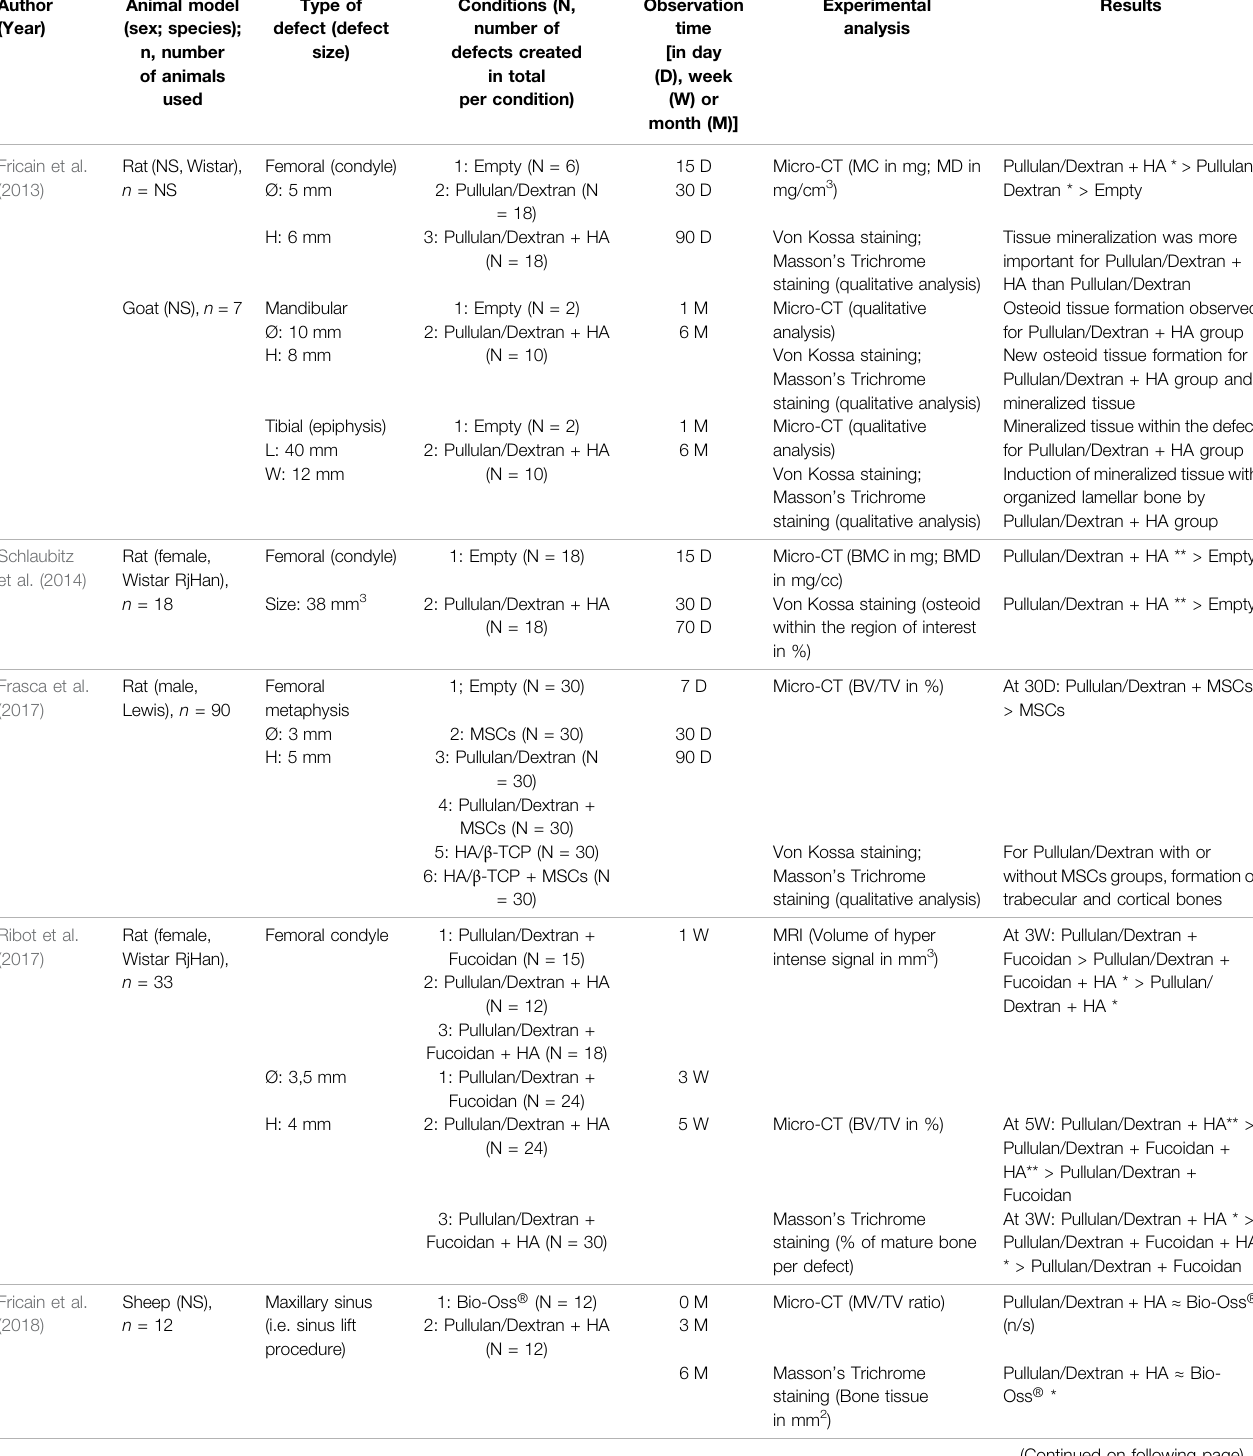
TABLE 5 | Preclinical studies using Dextran and Pullulan scaffolds for bone regeneration in orthotopic